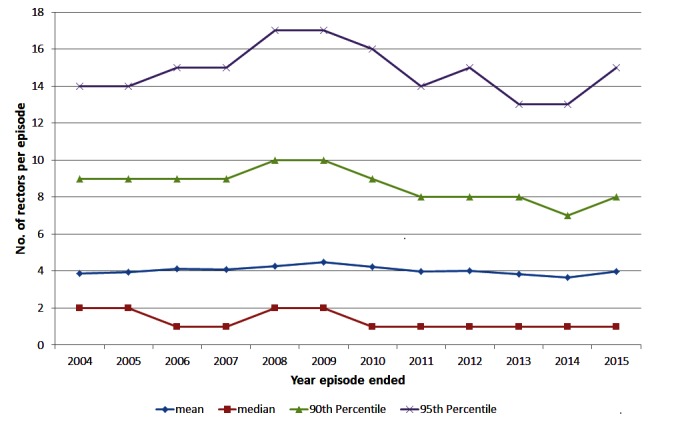
 The number (mean, median, 90th and 95th percentile) of reactors (standard/non-standard and animals with a bTB lesion at slaughter) in herds with a bTB episode ending in the year of interest, during 2004 to 2015 in Ireland.